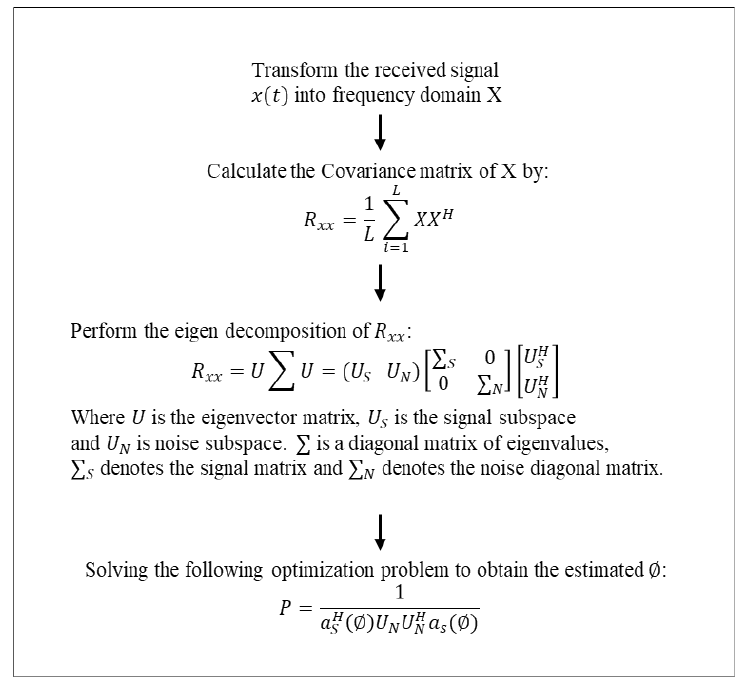
Figure 6. Flowchart of MUSIC algorithm [31].